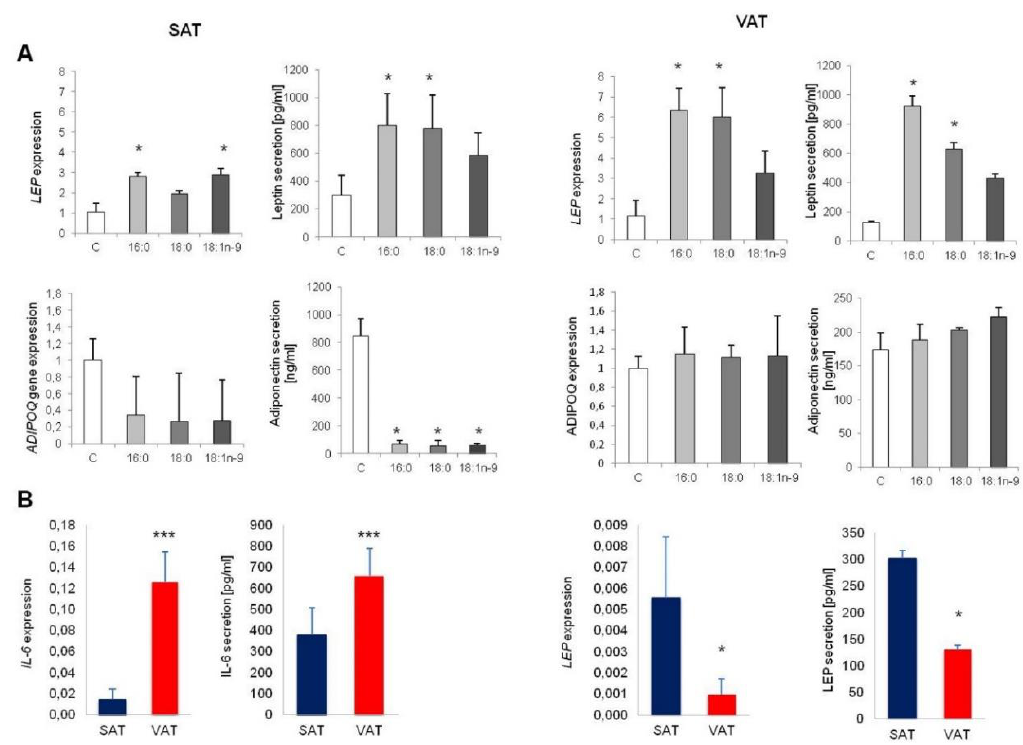
Figure 5. The adipokines expression and secretion in SAT and VAT adipocytes. Comparison of gene expression of control adipocytes and experimental cells (treated with palmitic acid (16:0), stearic acid (18:0), and oleic acid (18:1n−9)) obtained from SAT and VAT ( A ). Differences between Interleukin 6 (IL-6) and Leptin (LEP) expression and secretion between adipocytes obtained from VAT and SAT ( B ); * p < 0.05, *** p < 0.0001.